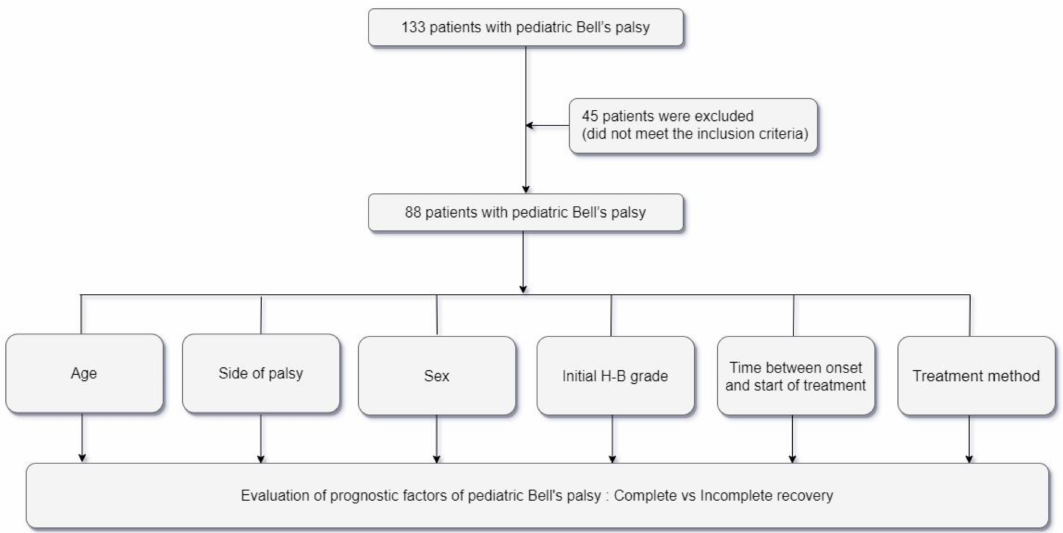
Figure 1. Flow diagram of the study design. H–B grade = House–Brackmann